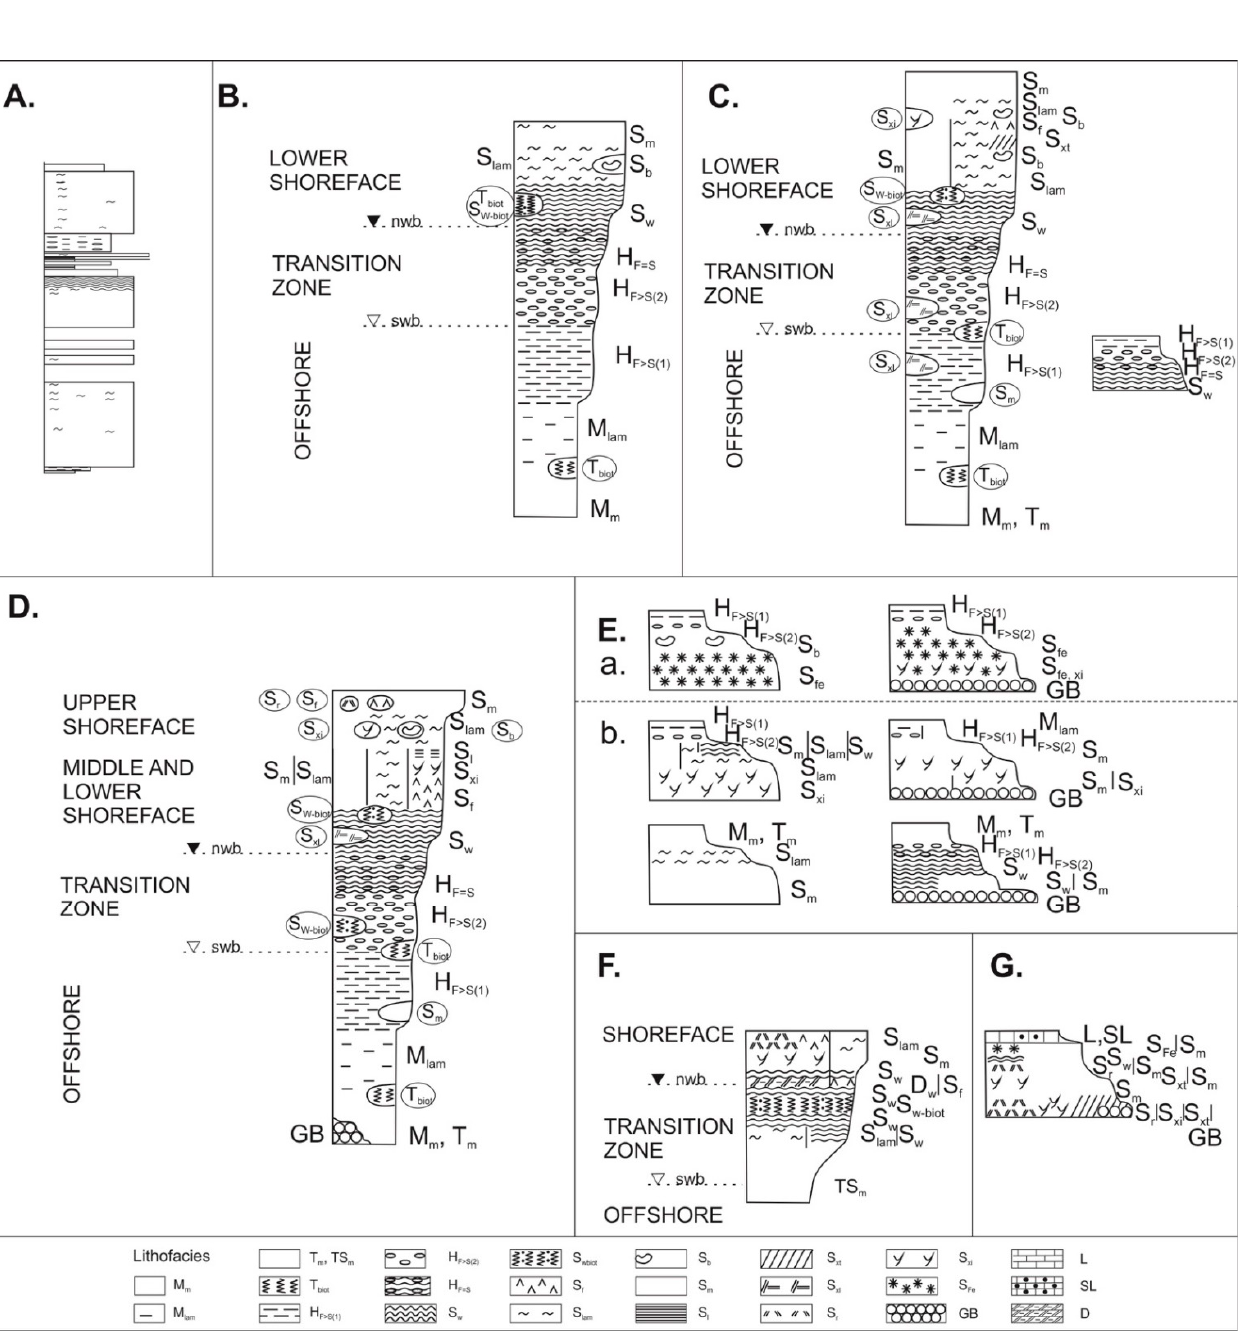
Figure 2. Vertical sequences of lithofacies observed in different stratigraphic divisions: ( A ) exemplary profile of the Lower Aalenian, ( B ) Upper Aalenian–Lower Bajocian, ( C ) Upper Bajocian, ( D ) Lower and Middle Bathonian—coarsening-up cycles, ( E ) Lower and Middle Bathonian—finning-up cycles; ( a ). cycles with green colour chamosite sandstones (lithofacies SFe), ( b ). cycles without green colour chamosite sandstones (lithofacies SFe), ( F ) Upper Bathonian–Callovian—coarsening-up cycles, and ( G ). Upper Bathonian–Callovian—finning-up cycles. Symbols of lithofacies and their descriptions are as in Table 1. nwb—normal wave base; swb—storm wave base; SFe—Fe.